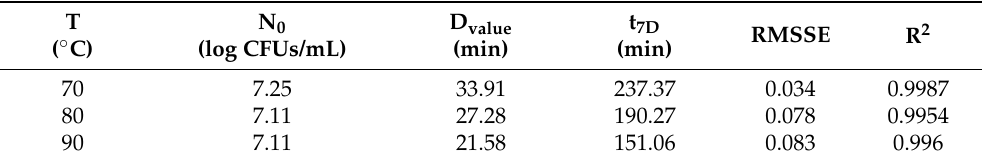
Table 1. The Weibull prediction model parameters for the heat resistance of S. aureus on textile swatches thermally treated in a heating